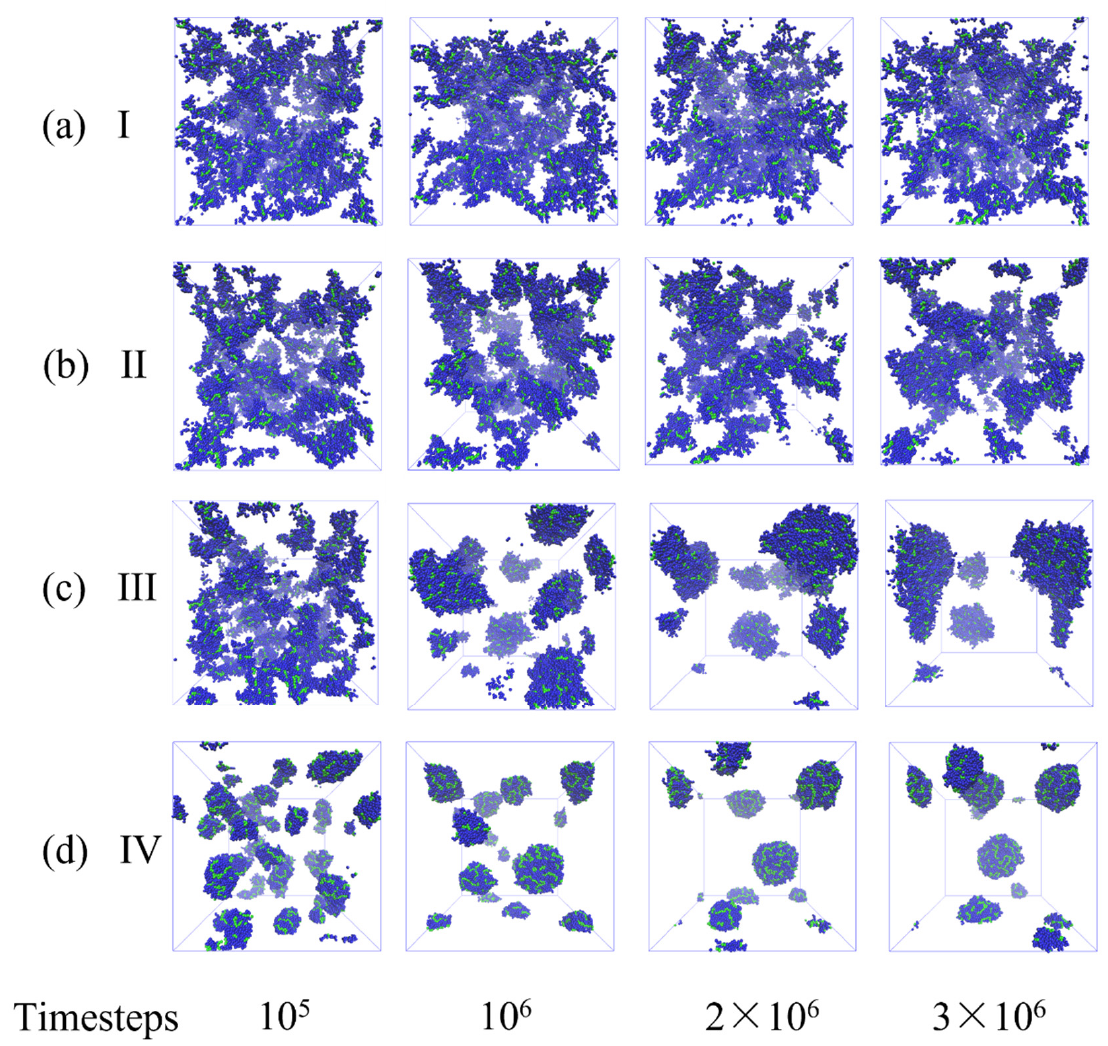
Figure 4. Representative snapshots of time evolution of n MBB = 77 bottlebrushes with N sc = 6 in solvents of various qualities: ( a ) a sc-sol = 78 (Case I), ( b ) a sc-sol = 83 (Case II), ( c ) a sc-sol = 84 (Case III), and ( d ) a sc-sol = 89 (Case IV). The snapshots correspond to the time steps provided below each column, the solvent is not shown for clarity of representation.